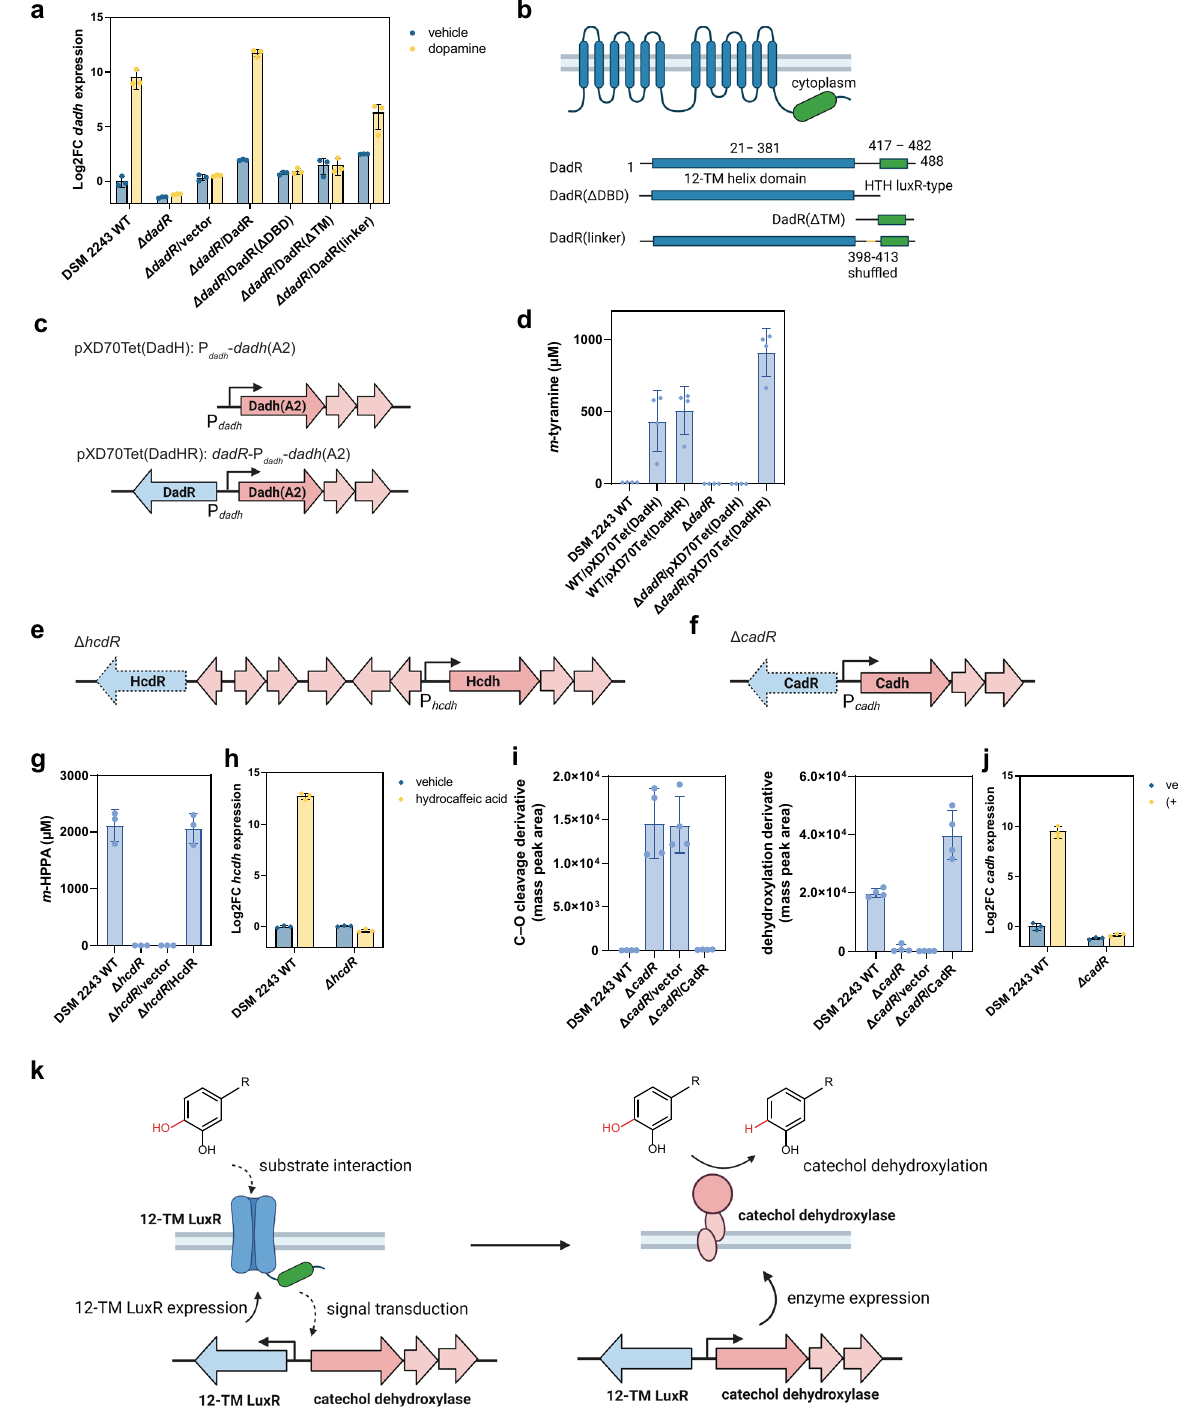
Fig. 6 | Gene deletion and complementation reveal that E. lenta DadR, HcdR, and CadR are transmembrane transcriptional activators. a RT-qPCR to test dadh upregulation on exposure to dopamine in E. lenta DSM 2243 WT, Δ dadR and complementation strains. b Schematic of the domain organization of DadR and DadR mutants examined in this work. c Schematic of pXD70Tet(DadH) and pXD70Tet(DadHR) constructs for testing the relevance of DadR for E. lenta dopa- mine metabolism. d LC-MS/MS to quantify the production of dopamine dehy- droxylation metabolite m -tyramine after incubation with corresponding E. lenta culturesfor 72h. e Deletionof hcdR in E.lenta DSM 2243 to generate Δ hcdR strain. f Deletion of cadR in E. lenta DSM 2243 to generate Δ cadR strain. g LC-MS/MS to quantify the production of hydrocaffeic acid dehydroxylation metabolite m -HPPA